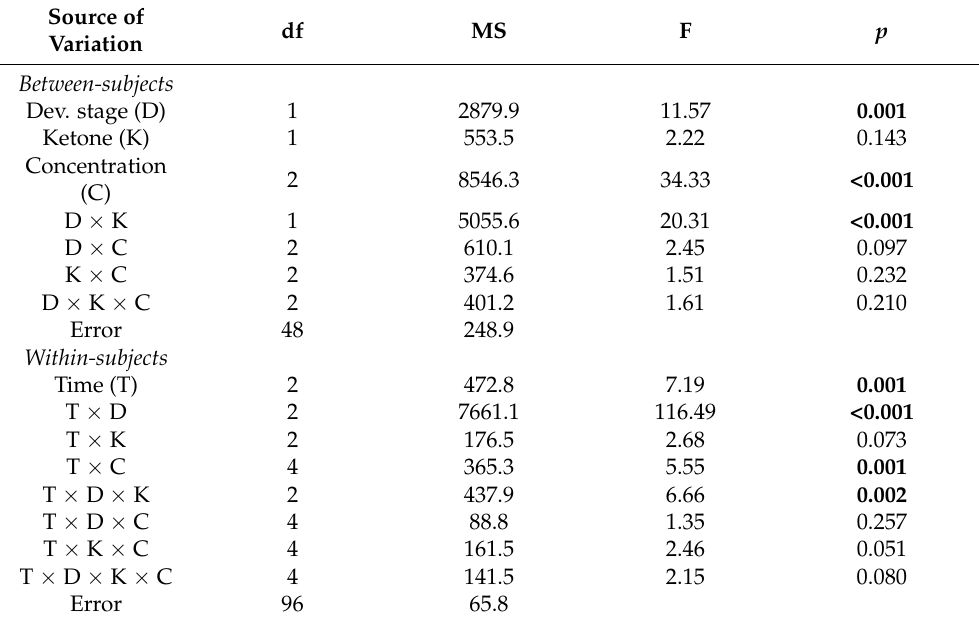
Table 2. Repeated measures ANOVA of the feeding reduction index during 48–96 h of exposure of CPB larvae and adults to different concentrations of camphor and the thujone-camphor mixture. Significant effects are given in bold.